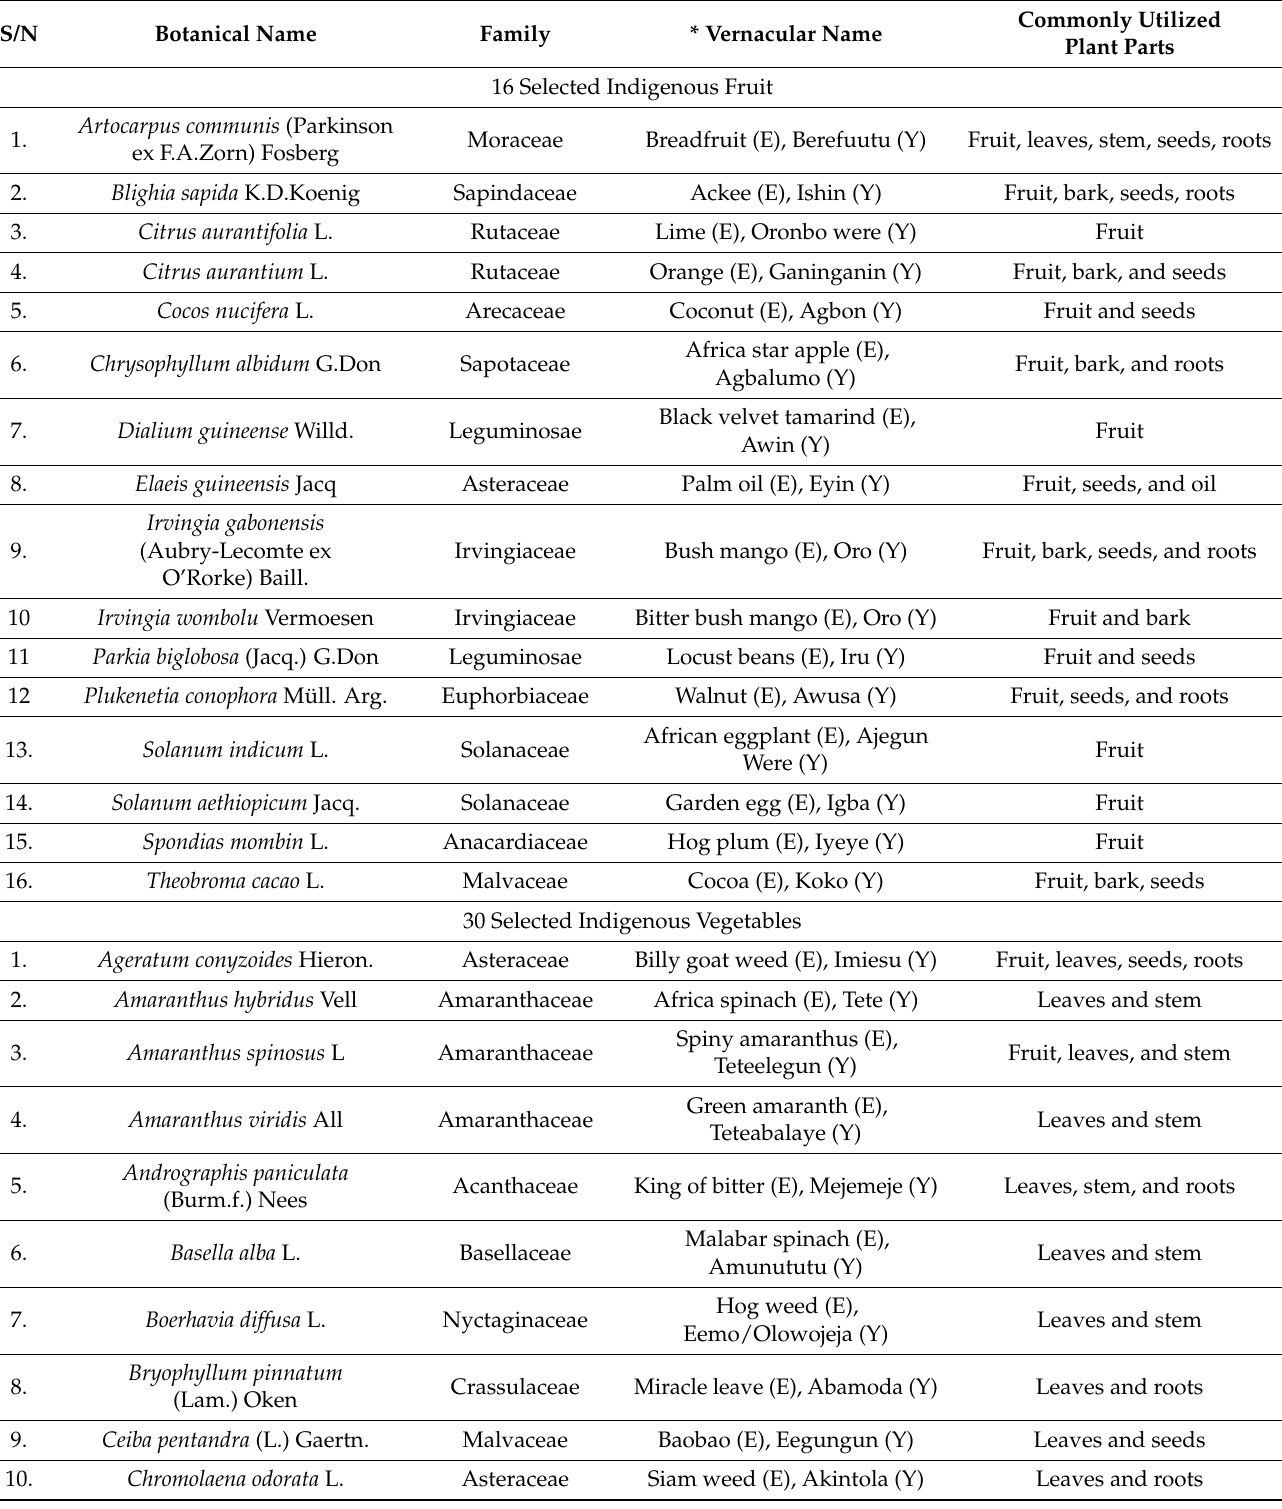
Table 1. Scientific names and families of the selected indigenous fruits and vegetables. The names were verified using the Plant List (http://www.theplantlist.org/: Accessed on the 20 December 2021). * Vernacular Names: E = English, Y =